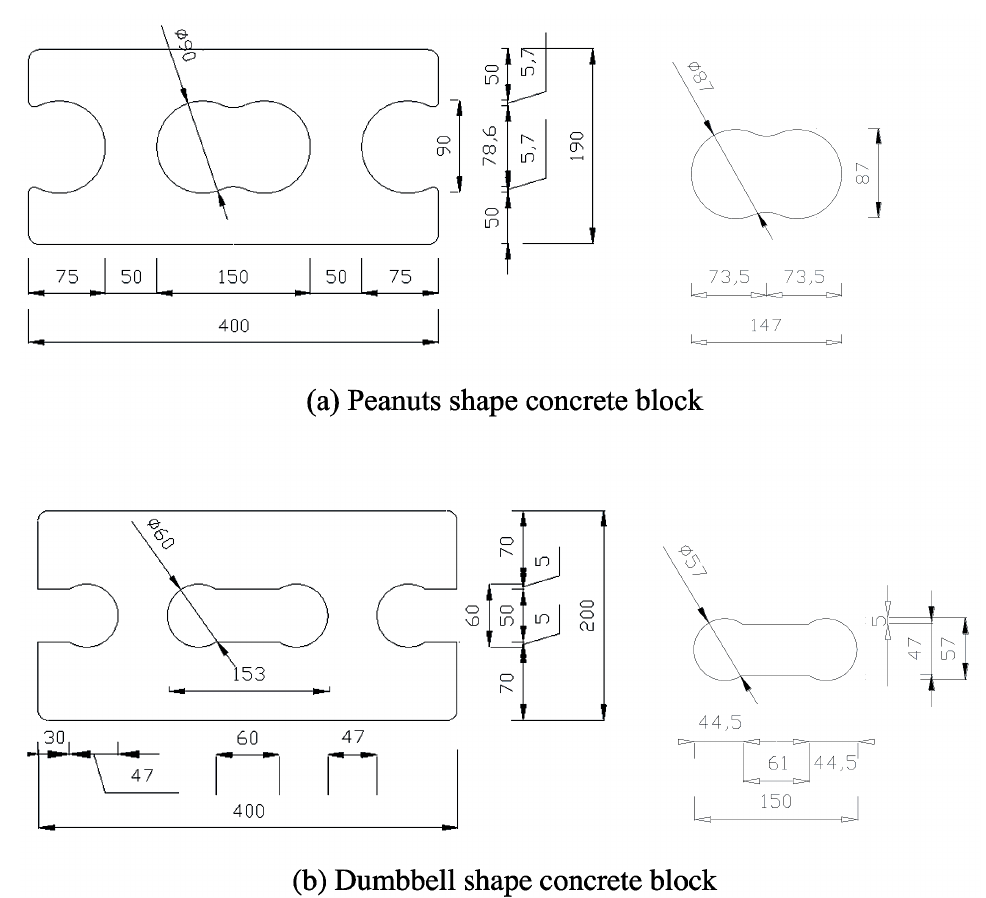
Figure 2. Two types of concrete block systems (unit: mm).